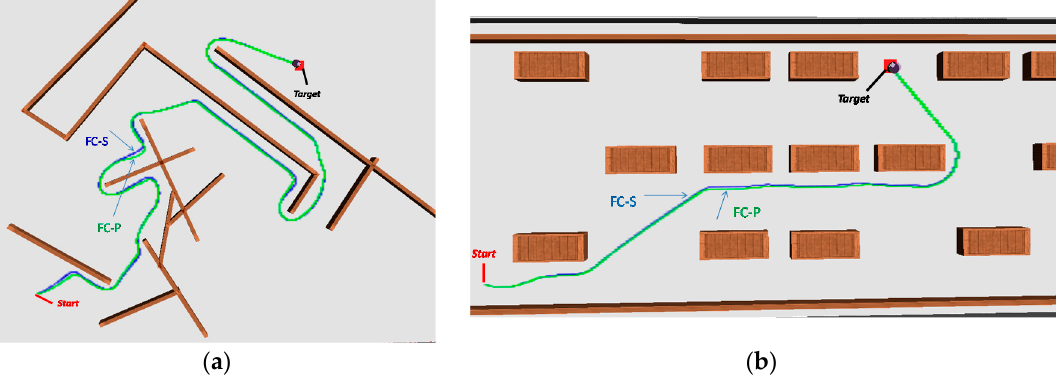
Figure 10. Navigation results using FC-P and FC-S in ( a ) unknown environment 1 and ( b ) unknown environment 2.